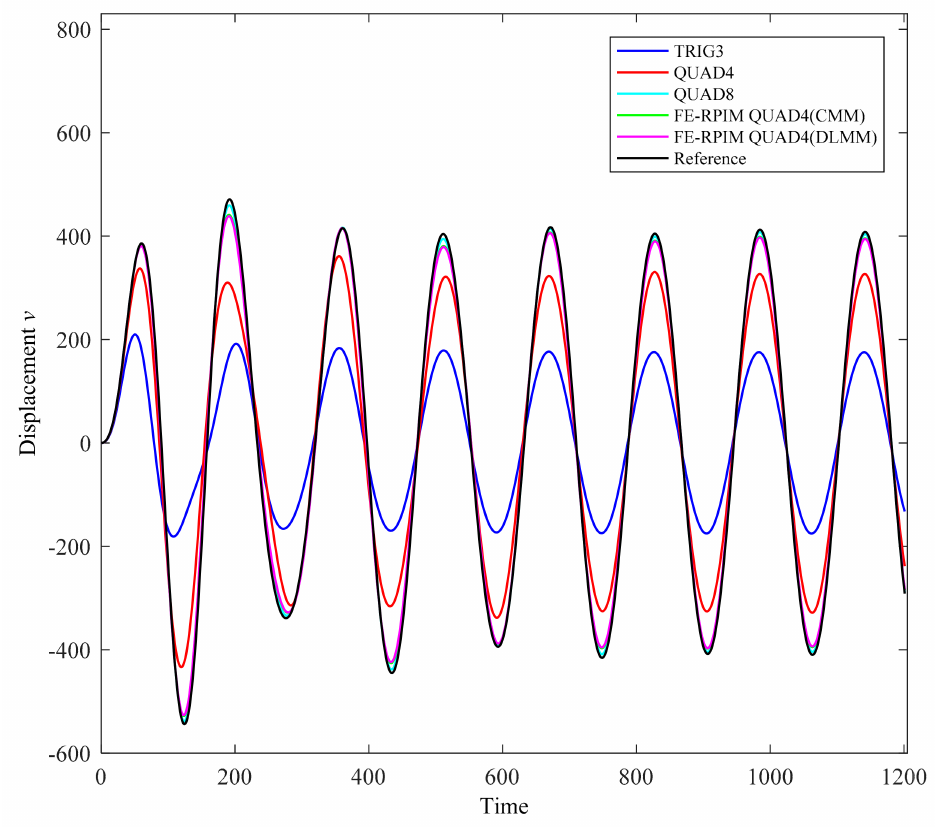
Figure 22. Transient responses of a cantilever beam subjected to a harmonic